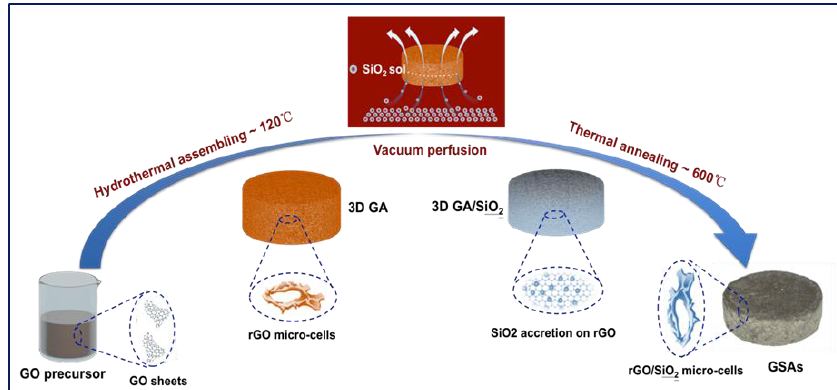
Figure 1. Schematic of graphene hybrid SiO 2 aerogel (GSAs) fabrication including grapheme oxide (GO) architecture formation by self-assembling GO sheets via hydrothermal chemical reaction. SiO 2 sol absorbing into porous GO architecture and in situ freeze-drying combined with subsequently thermal annealing to form GSAs with graphene templates and SiO 2 ceramics tightly integrated.